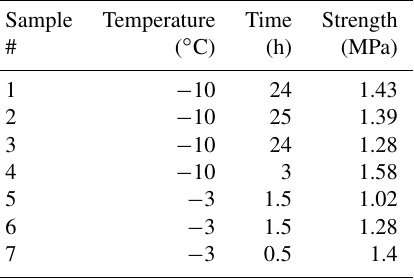
Table 1. Results from testing freshwater bond experiments. The time here is the bond formation time, and the strength is the flexu- ral strength (temperature during flexural testing and bond formation was the same). The reader should notice that in all of these experi- ments the failure occurred outside of the bond and within the parent material.